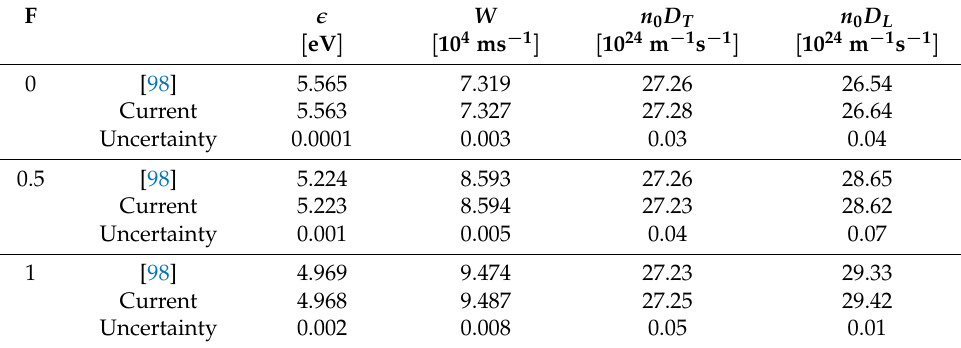
Table A1. Swarm benchmark results for Lucas and Saelee’s electron impact ionisation using the current MC code, presented alongside an independent solution to the Boltzmann equation [98]. Provided, for comparison, are the mean energy ( ε ), drift velocity ( W ) and the transverse ( D T ) and longitudinal ( D L ) diffusion coefficients for each value of F . Note that error estimates are given by the standard deviation of each transport coefficient with respect to time. For this benchmark 10 6 particles were simulated for n 0 t = 2 × 10 16 sm − 3 , where averages were conducted over the latter half of the simulation